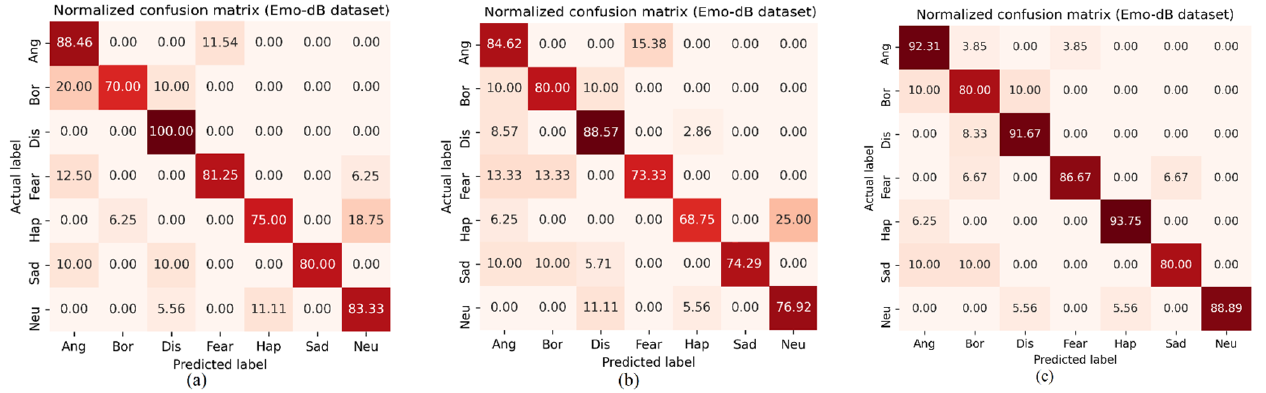
Figure 3. The confusion matrix on the EMO-DB dataset. ( a ) The Conv-Cap module with a UA of 82.57%, ( b ) the Bi-GRU module with a UA of 78.73%, and ( c ) the proposed model with a UA of